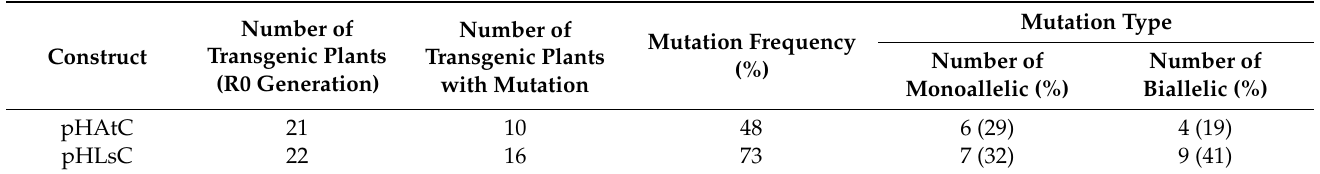
Table 2. Editing efficiency and mutation types of CRISPR/Cas9-mediated PHOT2 gene editing in R0 transgenic plants. Data were summarized from the data shown in Table